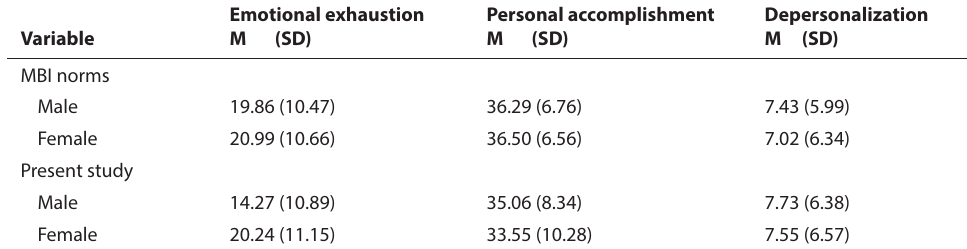
TABLE 2 Comparisons of Present Sample to Gender Norms on the Maslach Burnout Inventory